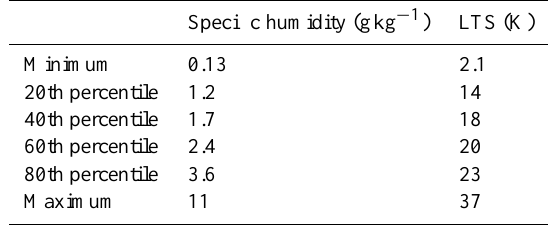
Table 5. Percentile values of specific humidity and LTS used to defined different regimes of the meteorological parameters.